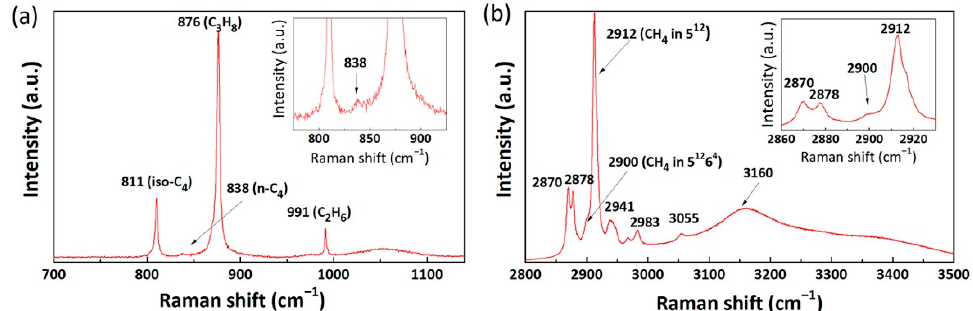
Figure 1. Raman spectra of the mixed gas hydrates. ( a ) C − C stretching vibrational modes ranged from 700–1350 cm − 1 , and ( b ) C − H stretching vibrational modes and O − H stretching modes ranged from 2800–3500 cm − 1 . The inset in Figure 1a shows the enlarged Raman band at 838 cm − 1 , whereas the inset in Figure 1b depicts the enlarged Raman bands ranging from 2860–2940 cm − 1 . Table 1. Assignments of measured Raman bands based on literature data.